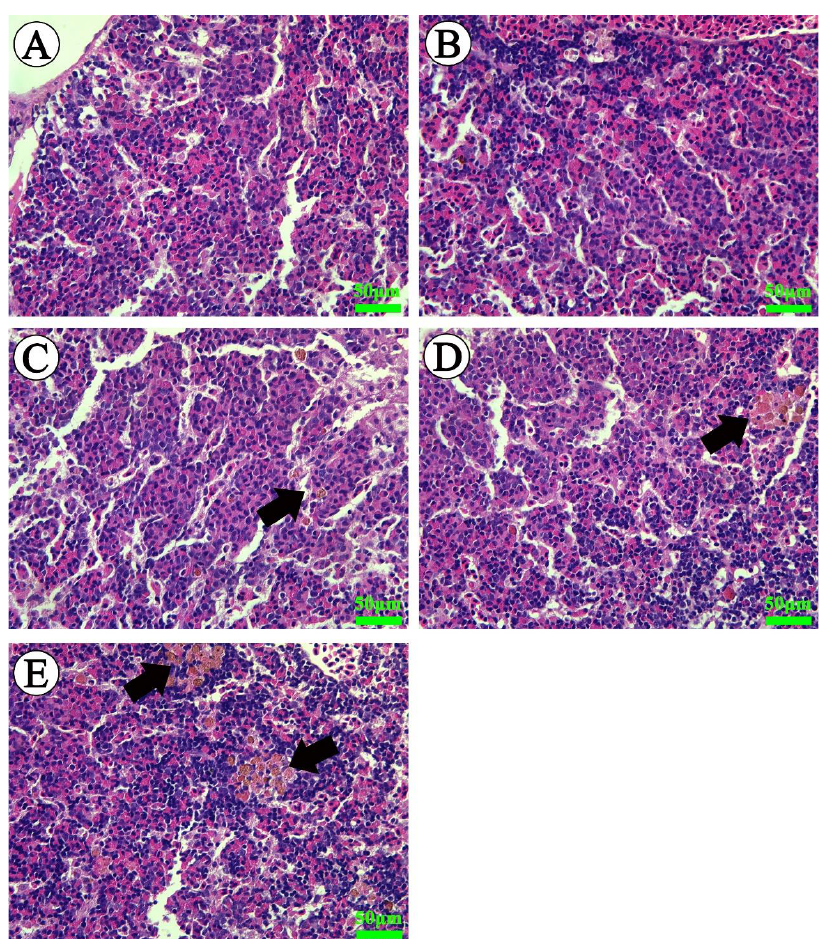
Figure 5. Light microscope photographs of head-kidney tissue of M. amblycephala (H & E). ( A , B ) The head-kidney of fish exposed to 0 and 5 mg/L ammonia nitrogen showing normal structure. ( C – E ) The head-kidney from fish exposed to 10, 20 and 30 mg/L ammonia nitrogen showing the increase in melano-macrophage centers in number and size (black arrows). Scale bar = 50 μm.